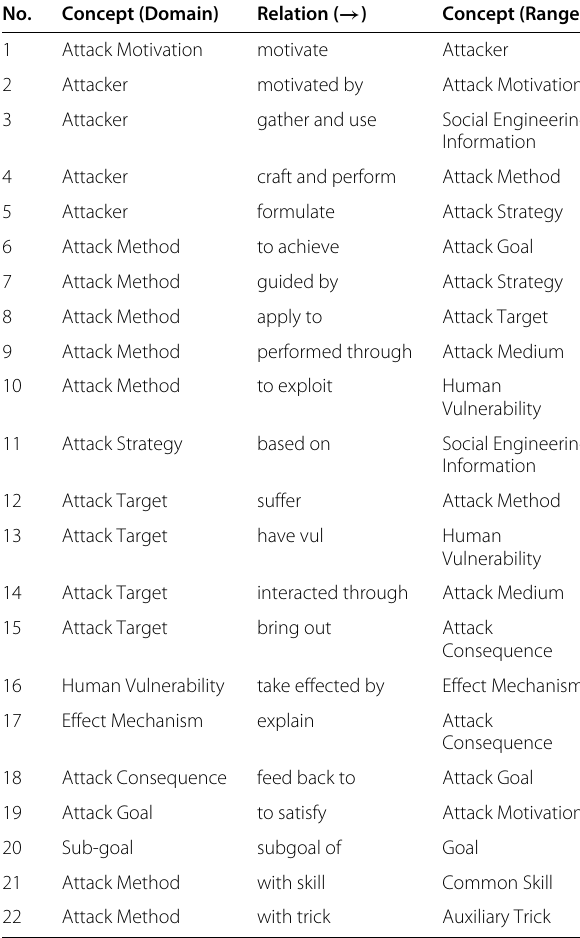
convenient for the instances’ creation. The built-in rea- soner HermiT can be used to implement the reasoning. For complex attack analysis, these rules might need